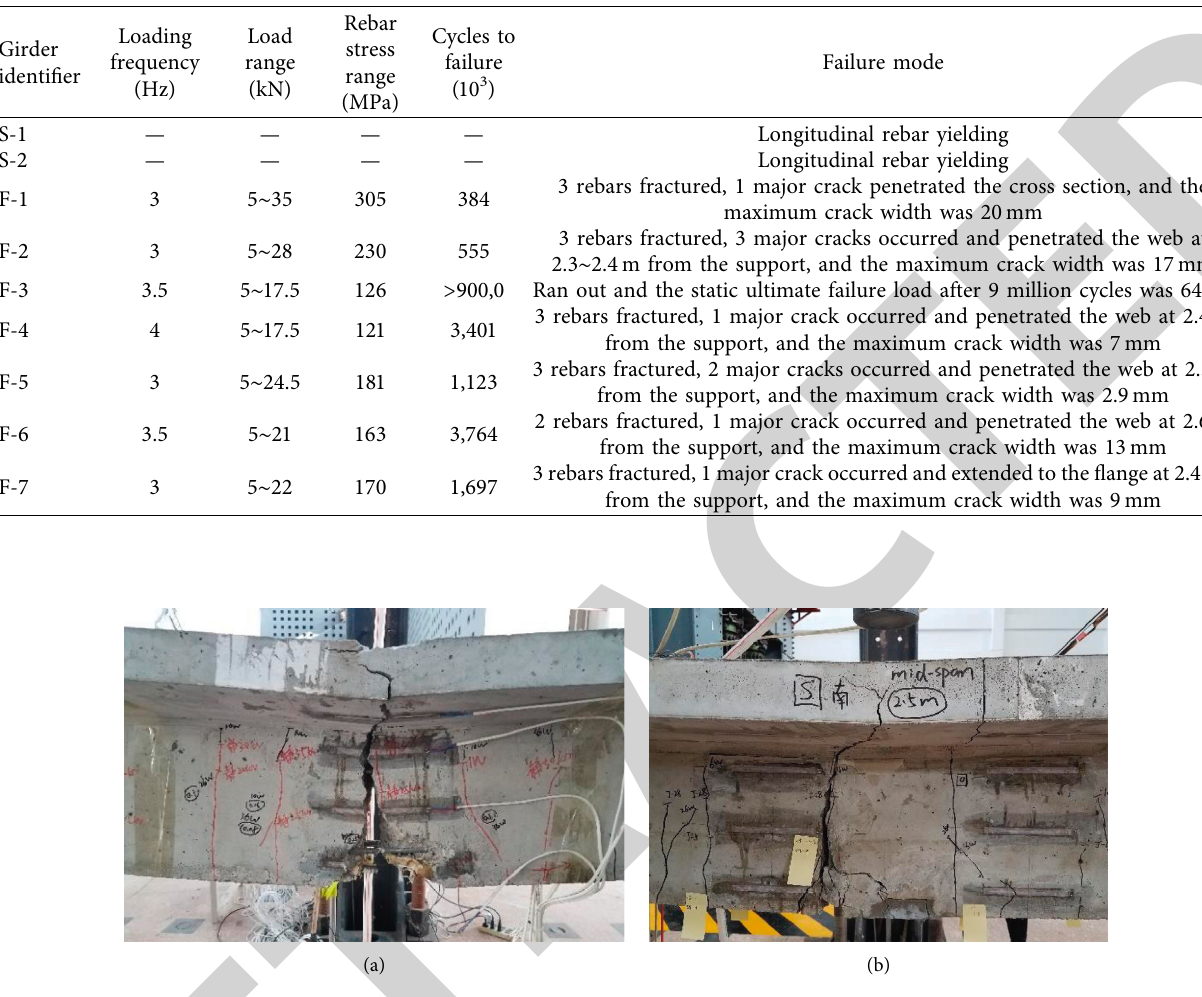
Figure 4: Typical fatigue failure modes of the test girders. (a) F-1 girder fatigue failure mode. (b) F-2 girder fatigue failure mode.